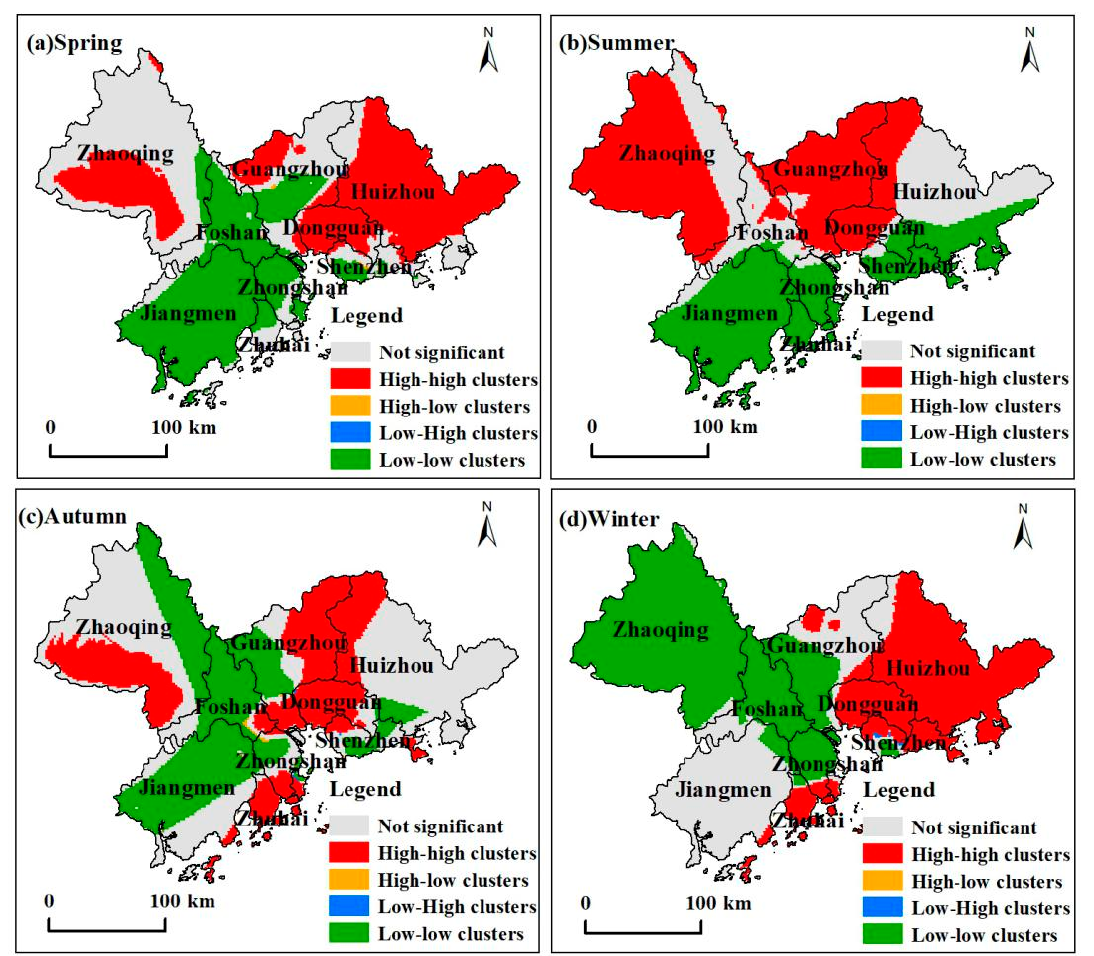
Figure 6. Local spatial autocorrelation of ozone concentration during spring, summer, autumn, and winter in the Pearl River Delta Metropolitan Region.